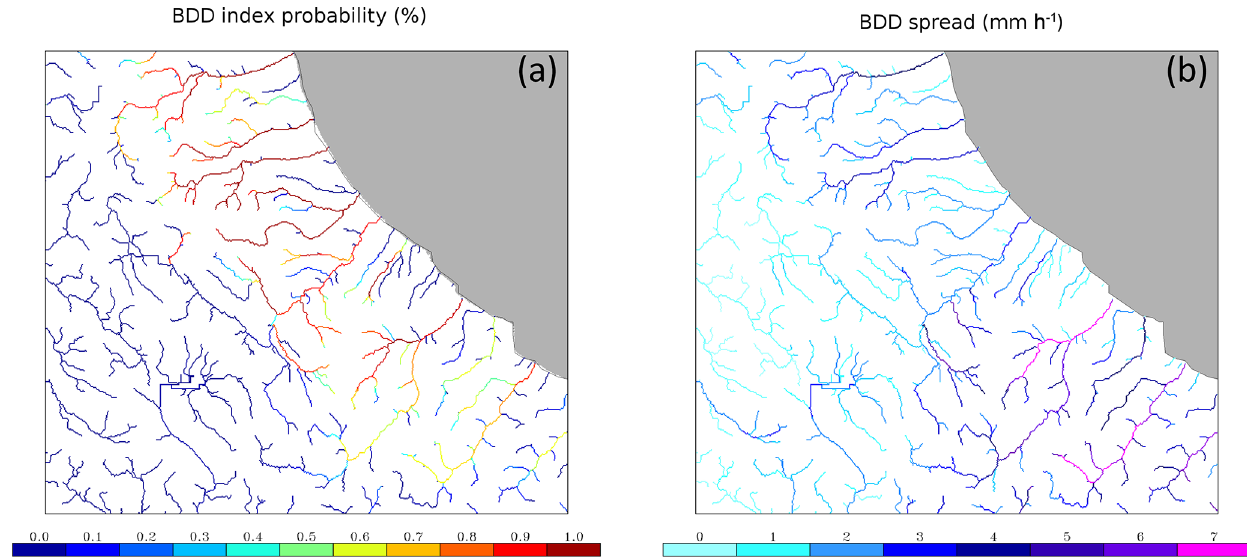
Figure 12. (a) The 24h BDD probability index computed forcing CHyM with the 21 WRF members. (b) CHyM ensemble spread.